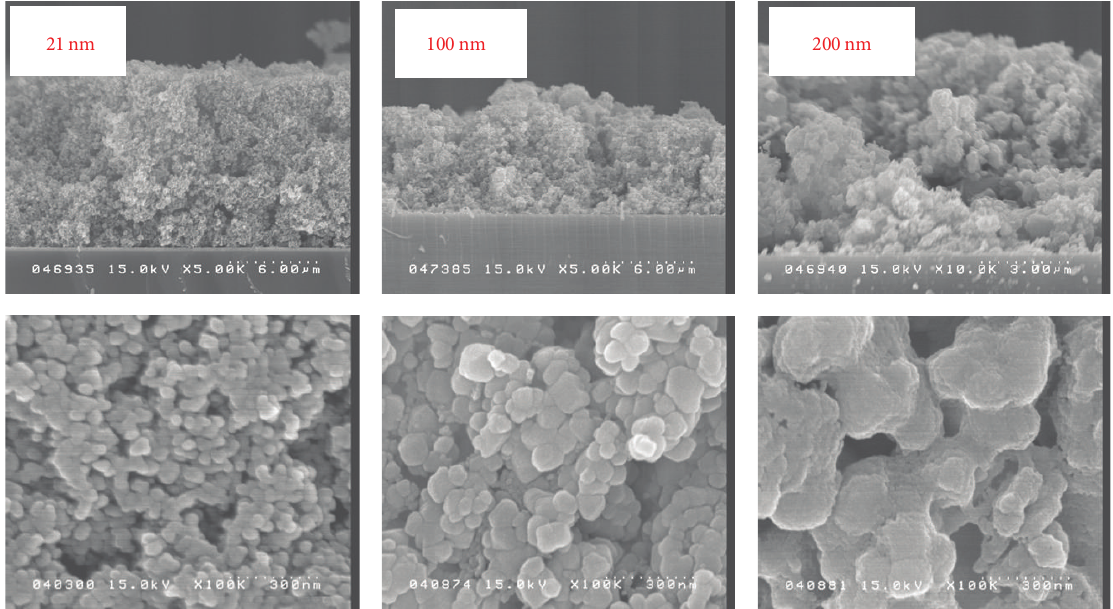
Figure 1: The cross section and surface-view field emission scanning electron microscopy (FESEM) images of a single TiO 2 layer with three different particle sizes of 21nm, 100nm, and 200 nm.